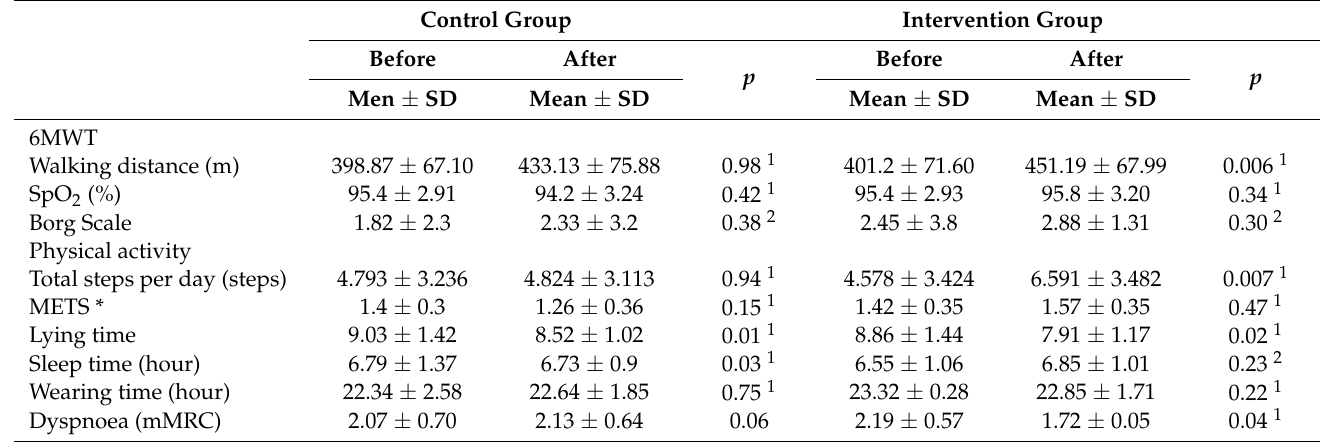
Table 2. Dyspnoea, submaximal exercise, and physical activity.